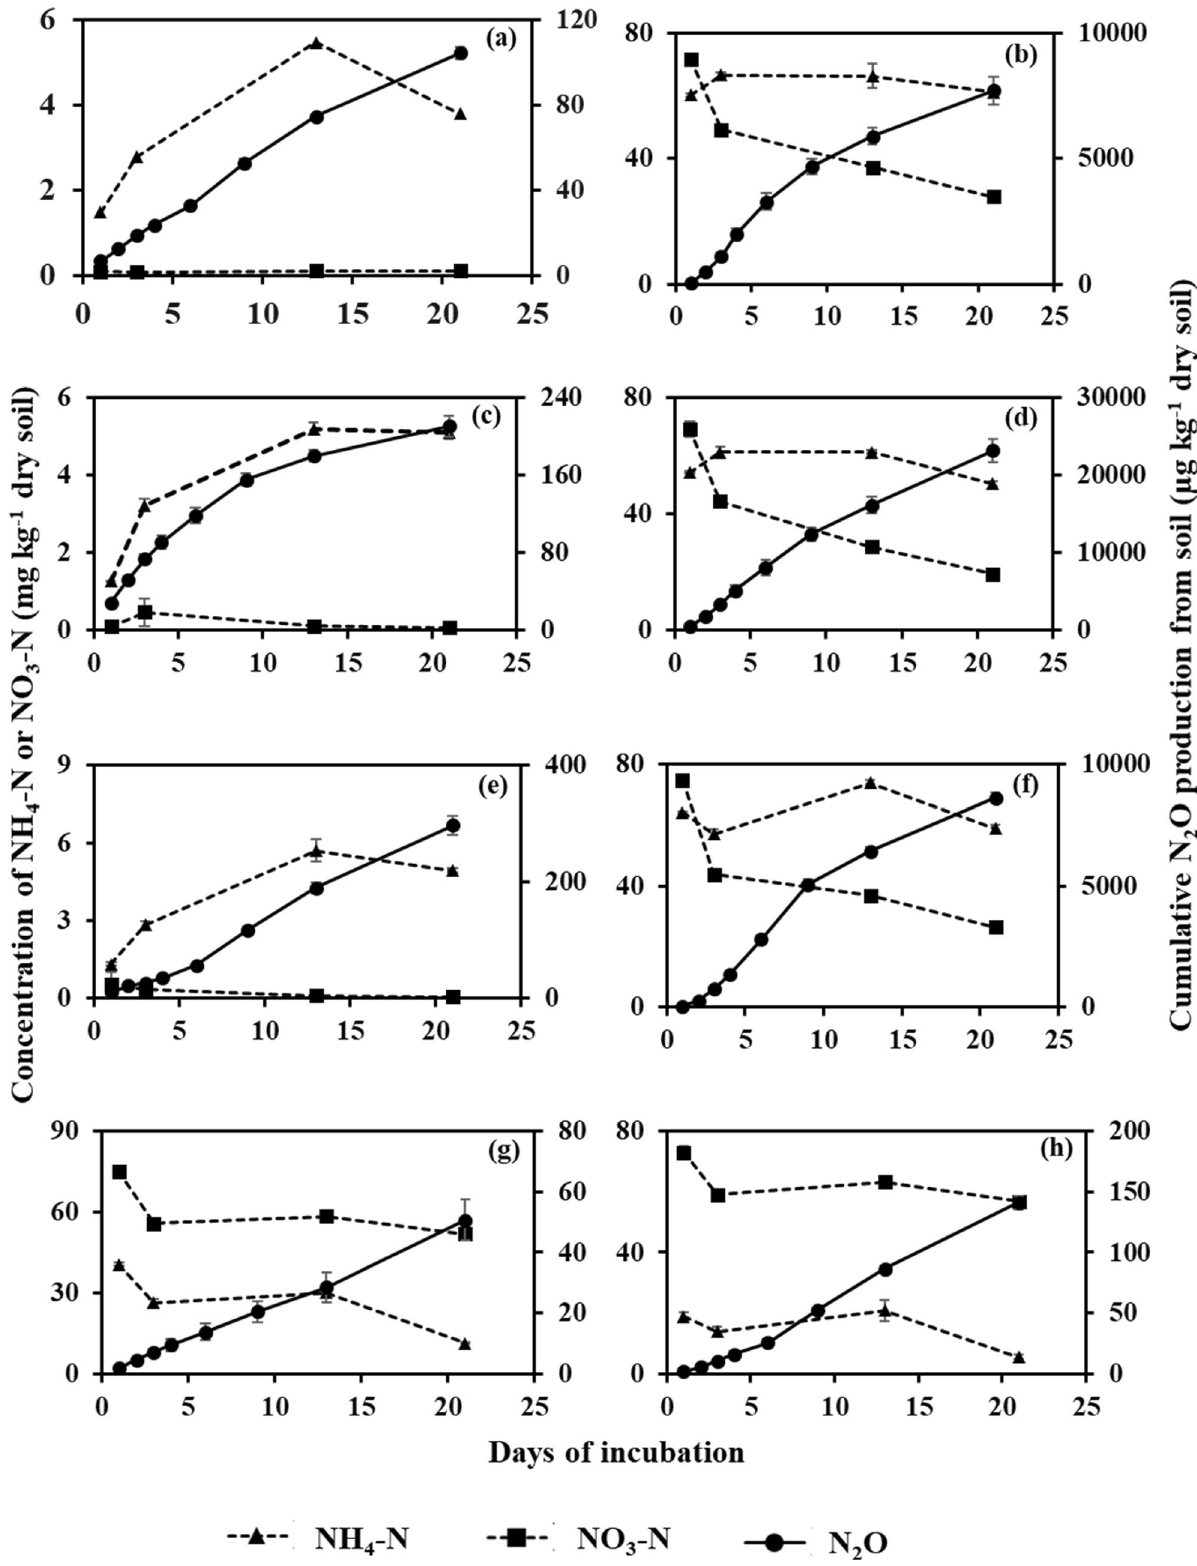
Figure 3. Cumulative N 2 O production, and mineral N concentration (NH 4+ and NO 3− ) in mineral soil (MS). A = Control soil only (S); b = Control soil with N fertilizer (S + N); c = Control soil with corn residue biochar (S + CB); d = Control soil with corn residue biochar and N fertilizer (S + CB + N); e = Control soil with pine bark biochar (S + PB); f = Control soil with pine bark biochar and N fertilizer (S + PB + N); g = Control soil with N fertilizer and calcium peroxide (S + N + CPO); h = Control soil with N fertilizer and magnesium peroxide (S + N + MPO). Bar represents standard error, n =